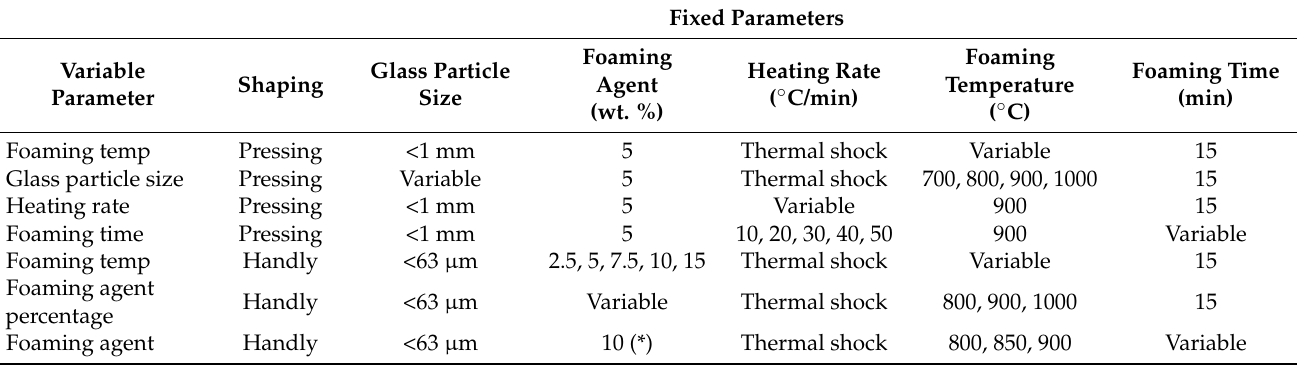
Table 1. Processing parameters used in the different foaming tests. Fixed